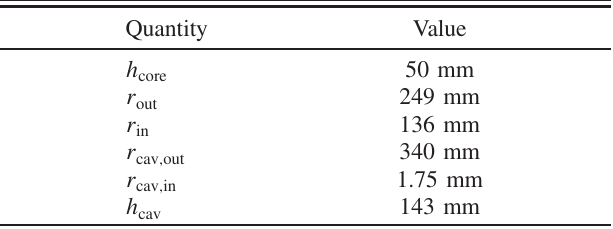
TABLE II. Dimensions of the cavity and the ring cores. The quantities are illustrated in Fig.